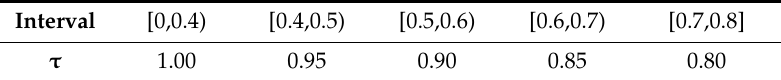
Table 1. Parameter settings for multi-level matching.